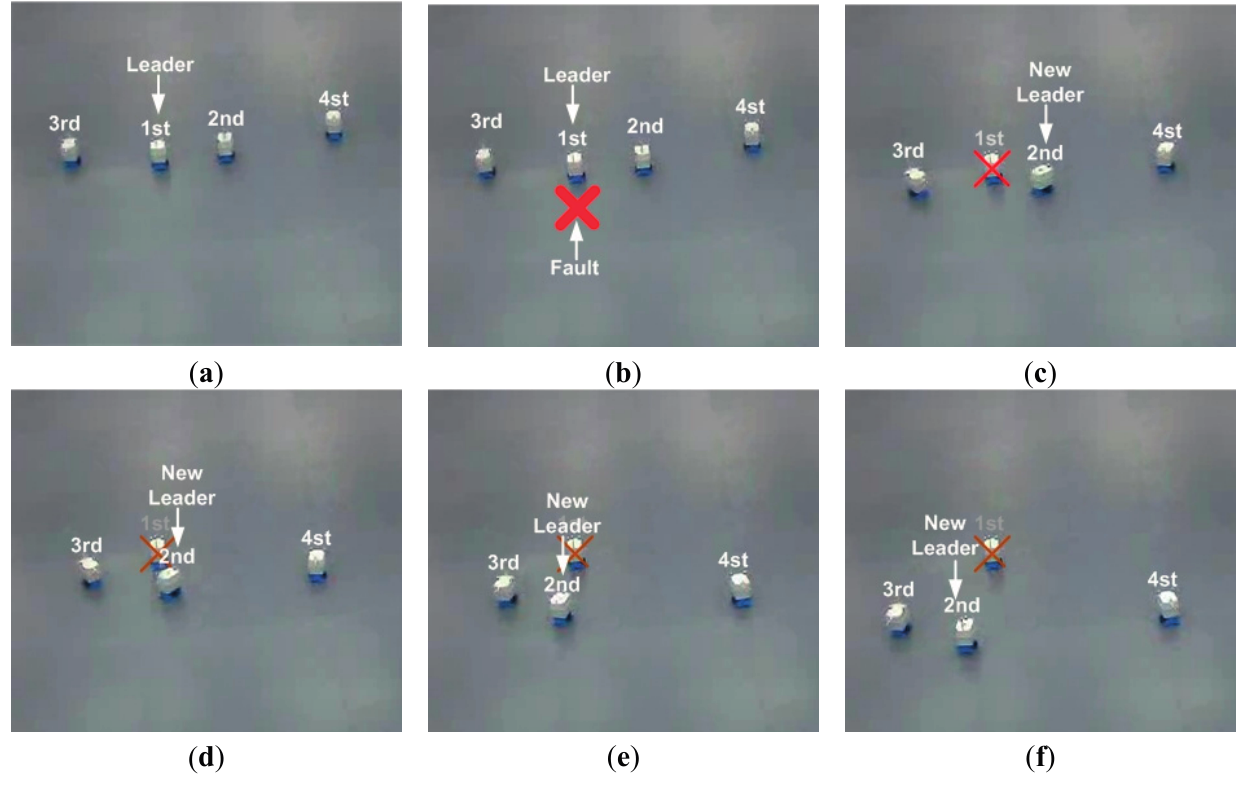
Figure 15. The snapshots of the situation of the fault of the